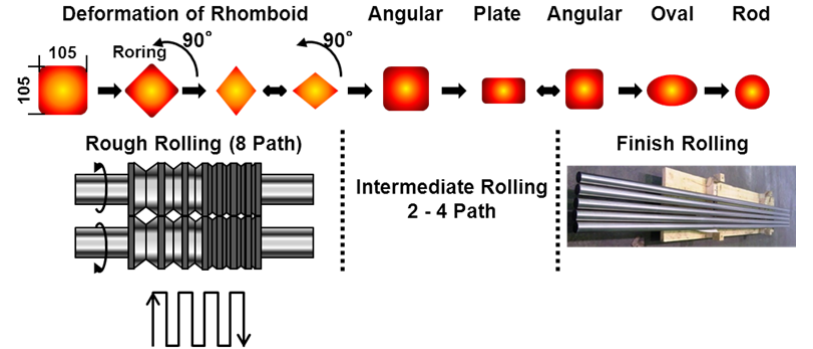
Figure 2. Schematic illustration of continuous hot rolling of Ti alloy to rod